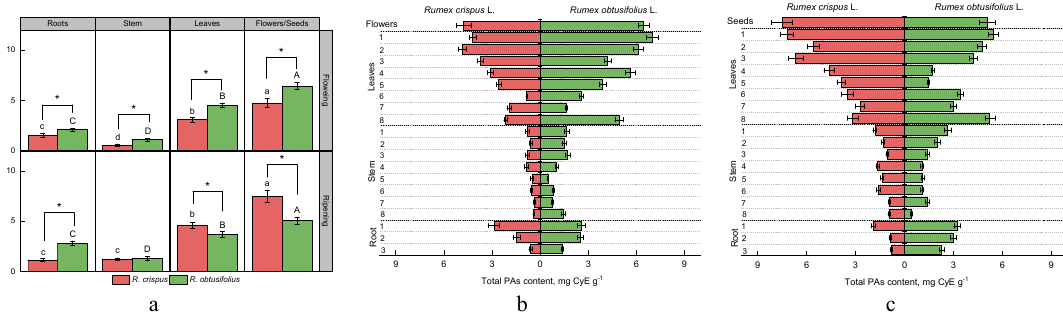
Figure 3. The content of proanthocyanidins in different parts of plants R. crispus and R. obtusifolius at flowering and fruiting stages ( a ), and vertical distribution of proanthocyanidins at flowering stage ( b ) and at fruiting stage ( c ). Different lower case letters indicate significant differences among plant parts of R. crispus ; upper case letters indicate significant differences among plant parts of R. obtusifolius ( p ≤ 0.05); asterisk * indicates significant differences among sorrel species ( p ≤ 0.05) based on post hoc Tukey’s tests separately for each growth stage.